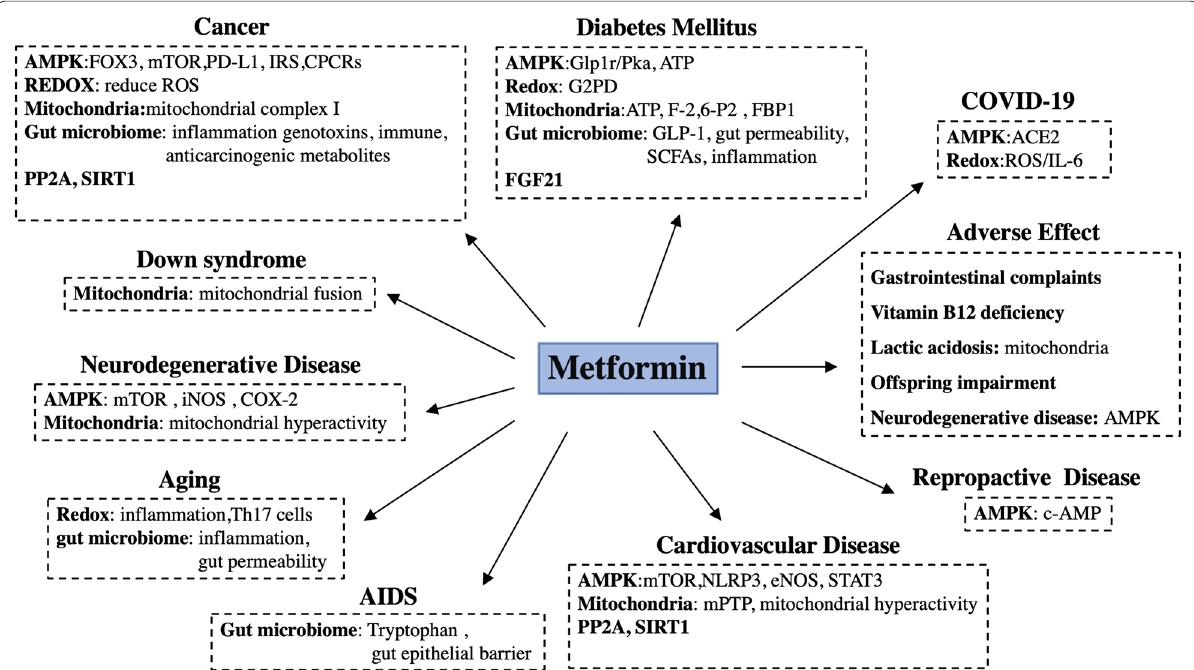
Fig. 4 Summary of metformin in different diseases and the major related mechanism. Based on its mechanisms, metformin has potential beneficial for diabetes mellitus, cancer, neurodegenerative disease, aging, cardiovascular disease, reproductive disease, COVID‑19, and even Down syndrome and AIDS, however, it is also companied with some adverse effect, including gastrointestinal complaints, vitamin B12 deficiency, lactic acidosis, offspring impairment and neurodegenerative